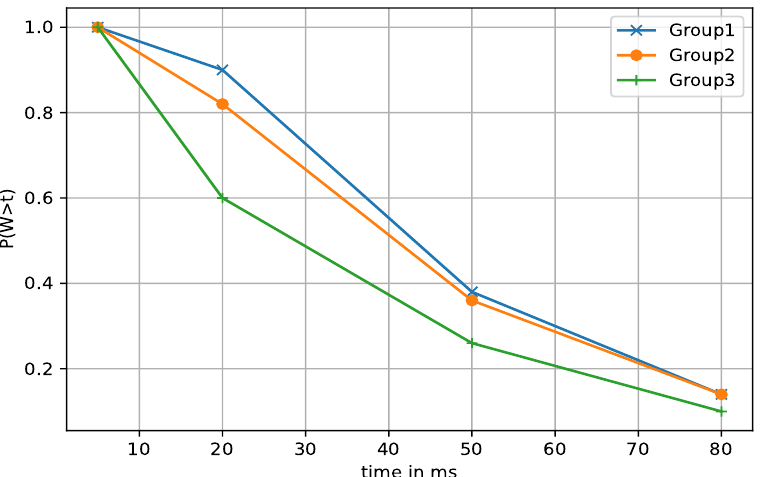
Figure 8. DQN’s waiting time distribution measured at different groups of episodes in random access network environment.